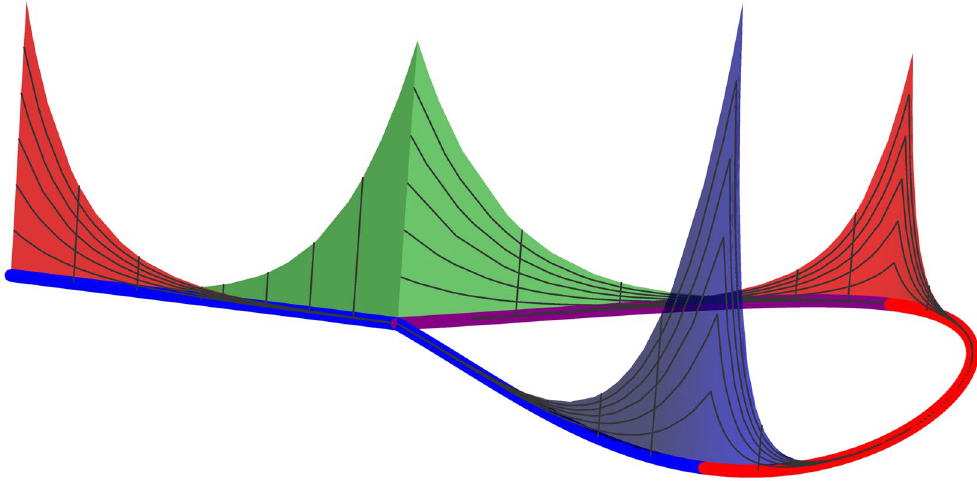
Figure 1. A three-dimensional illustration of the Majorana bound states in the Kitaev model with a T-junction. The chain contains two “topological” regions (the blue line, with N 1 sites, and the purple line, with N 2 sites) and one “trivial” region (the red line, with M sites). The T-junction is located at the site N 0 . The peaks represent the absolute values of the real-space amplitudes of the Majorana zero modes calculated for N 1 = M = 20, N 2 = 10, and N 0 = 11. The model exhibits four Majorana zero modes (corresponding to the nearly four-fold degeneracy of the ground state). Two of them are localized at a single interface point each: the dark blue at the site N 1 and the green at the T-junction. Note, that this amplitude is spread over only two (out of three) branches at the junction. The remaining two zero modes are delocalized between two interface points, the sites 1 and N 1 + M . One of them is illustrated by the red peaks.